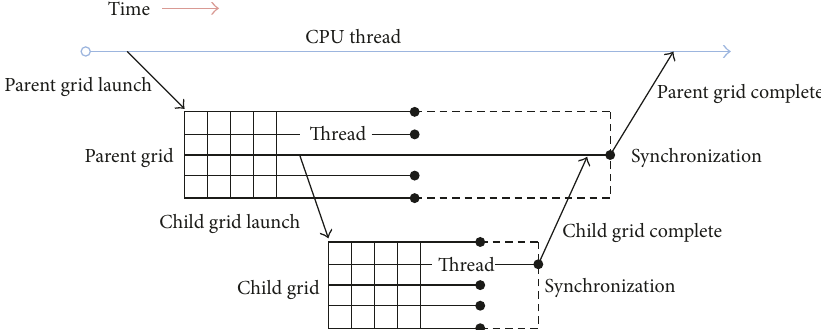
Figure 3: Flowchart of dynamic parallelism.